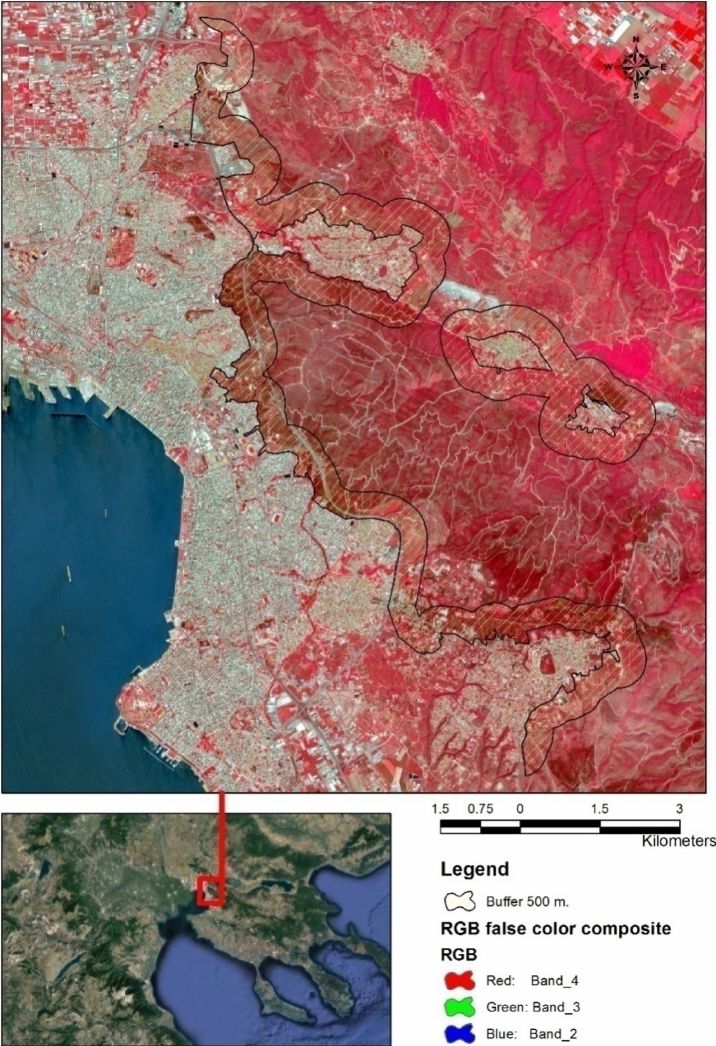
Figure 1. Sentinel-2 images used for the land cover mapping of the study area (May 2021). An external buffer (500 m) outside the city borders is shown, determined as WUI category I